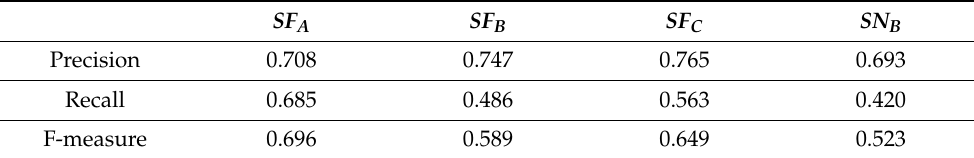
Table 3. Comparison of the rebar-exposure detection